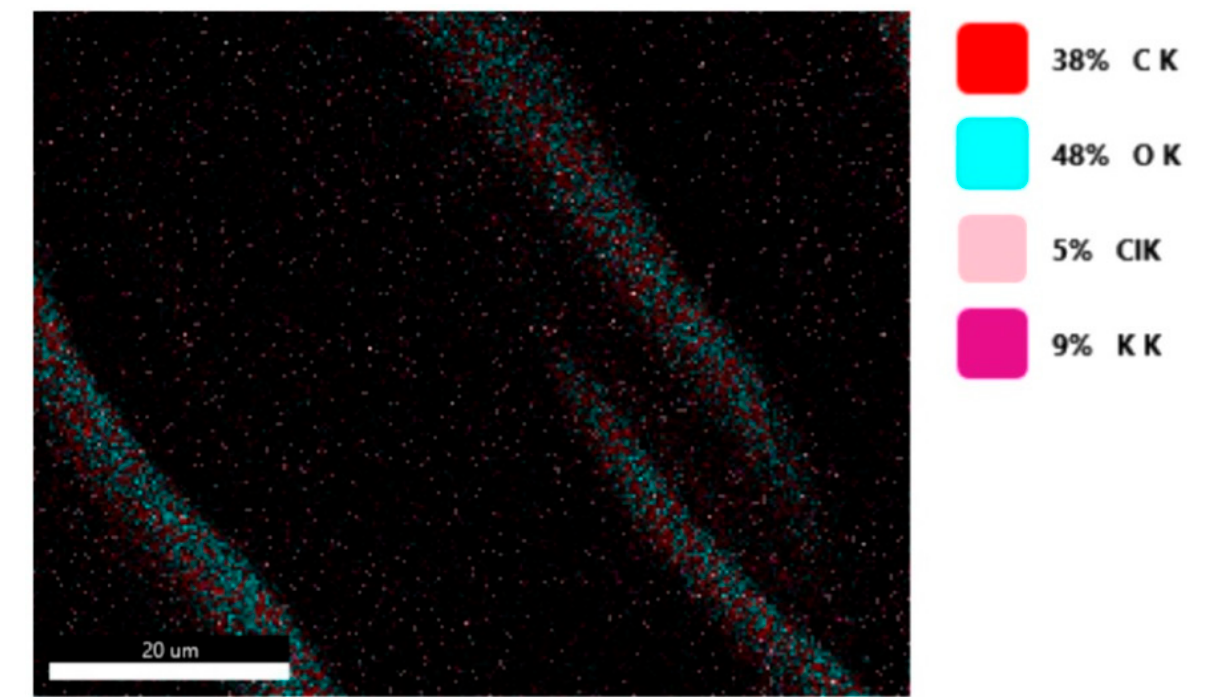
Figure 12. ESD spectra for sample S2 treated in RF plasma O 2 , using RF 1 generator and power 200 W.